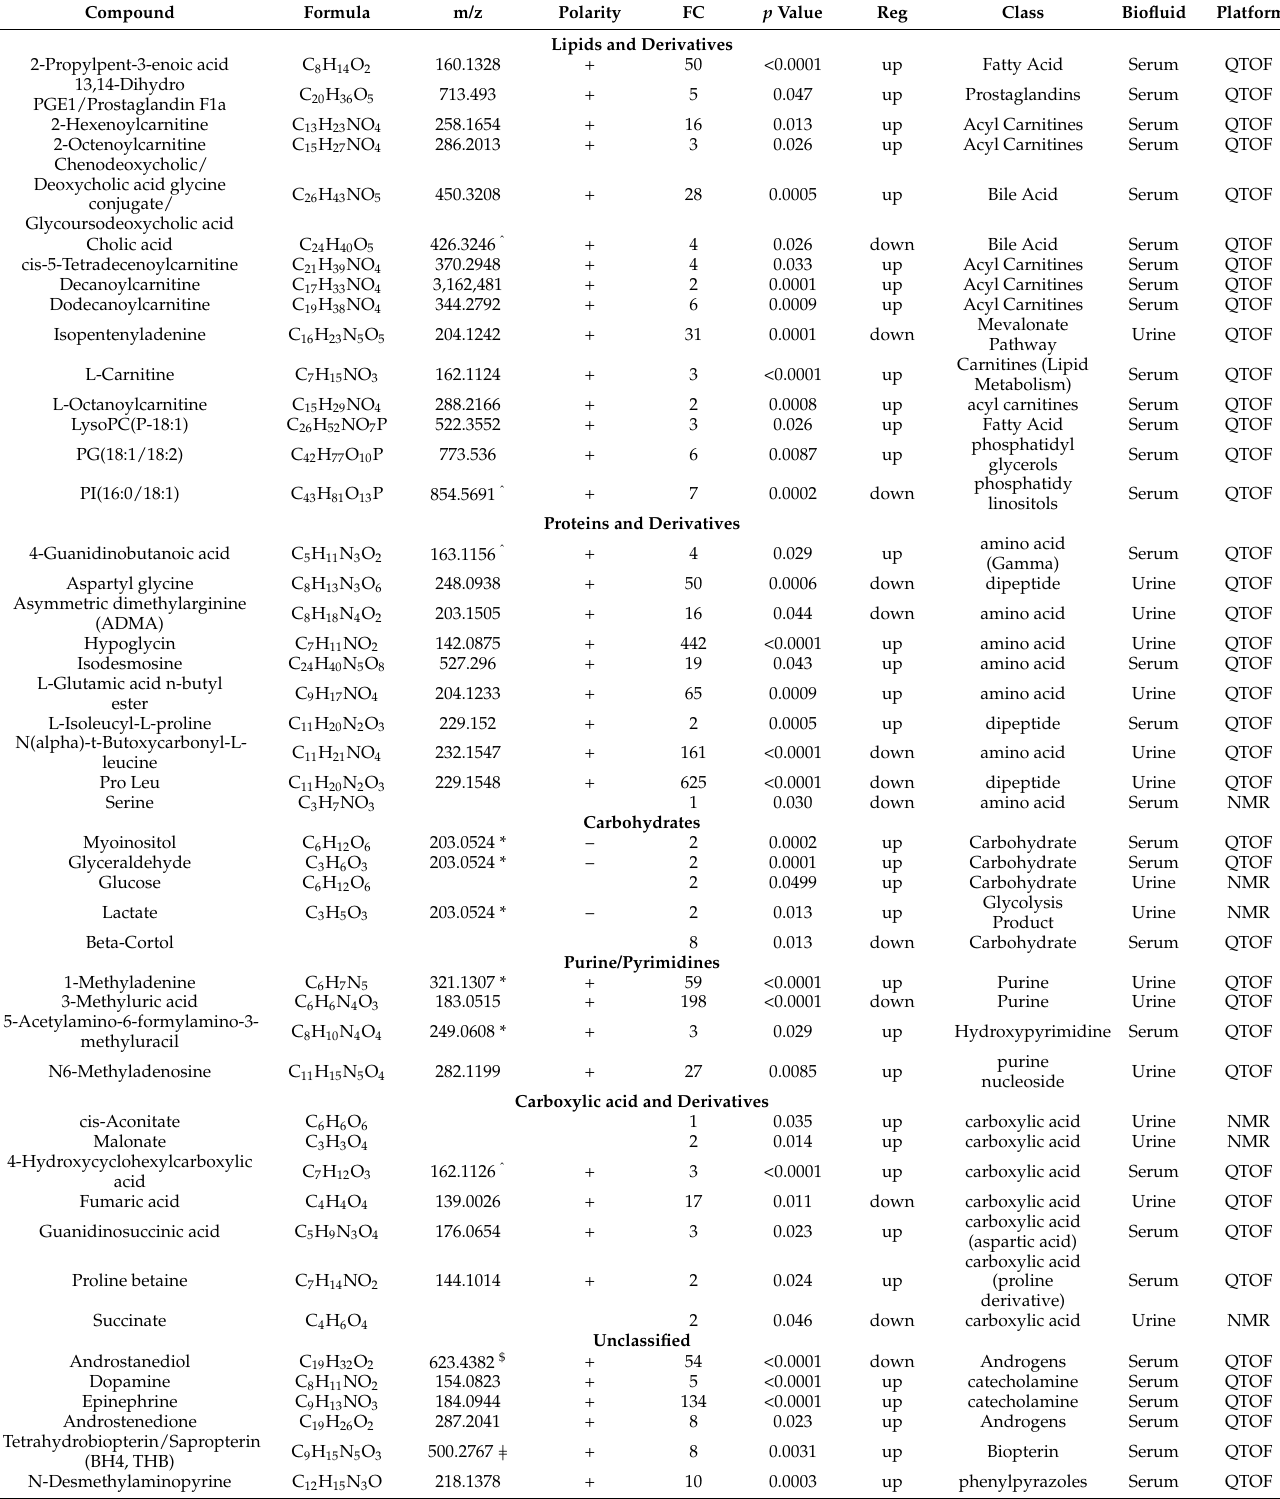
Table 2. Classification of altered metabolites of